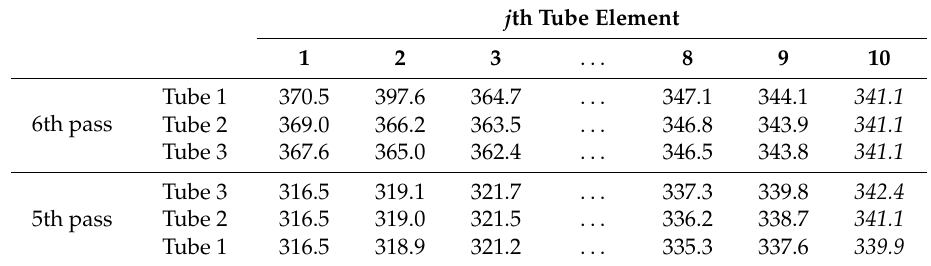
Figure 7. Channel system of the steam superheater discussed here: ( a ) schematic of the real flow geometry, and ( b ) representation of the heat exchanger using virtual mixing headers. Table 2. Steam temperatures in the inlet and outlet zones of the tubes in the last two tube passes.